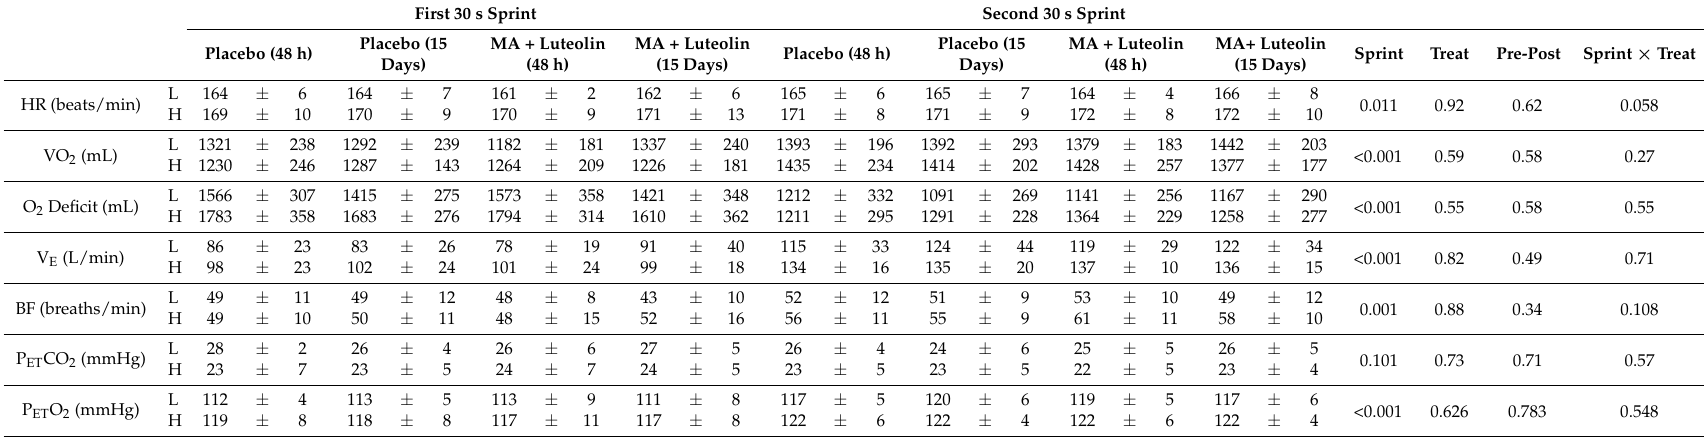
Table 3. Effects of mangiferin and luteolin botanical extracts on heart rate and pulmonary gas exchange during the 30-s all-out sprint (Wingate tests) performed after a 30 min recovery period and interspaced by 4 min of unloaded